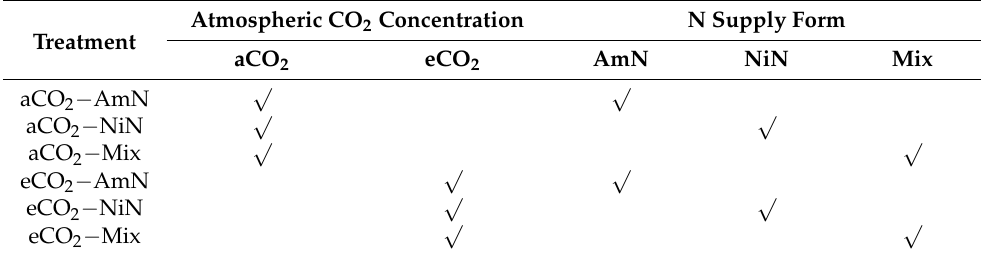
Table 1. Six treatments of the experiment. Atmospheric CO 2 Concentration N Supply Form Treatment aCO 2 eCO 2 AmN